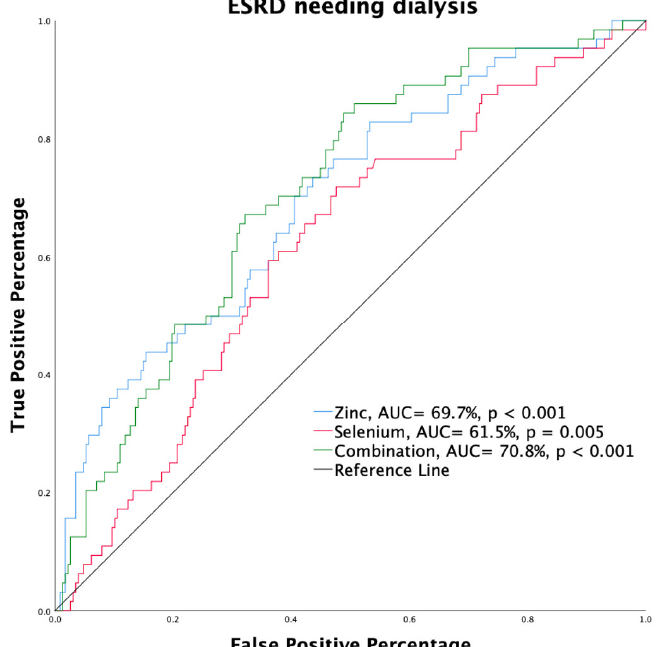
Figure 2. A receiver operating characteristic curve illustrating the performance of low zinc (AUC: 69.7%, p < 0.001) and selenium (AUC: 61.5%, p = 0.005) levels and their combination, obtained by multiplying both values, (AUC: 70.8%, p < 0.001) in predicting the development of end-stage renal